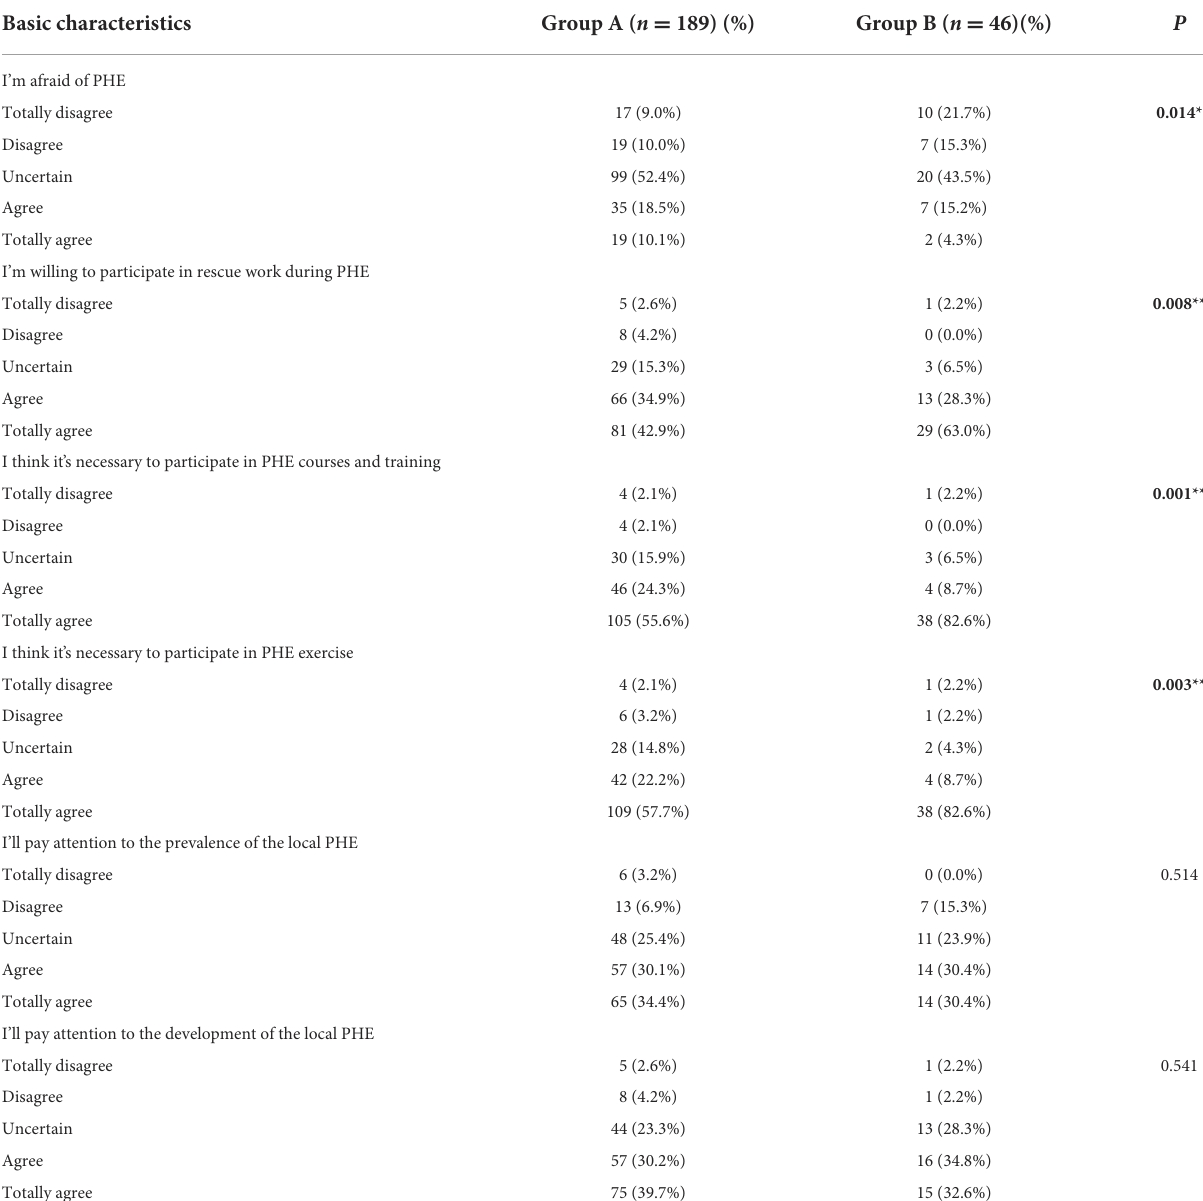
TABLE 2 Comparison of the subjective cognition in public health emergency between clinical and preventive medical students. Basic characteristics